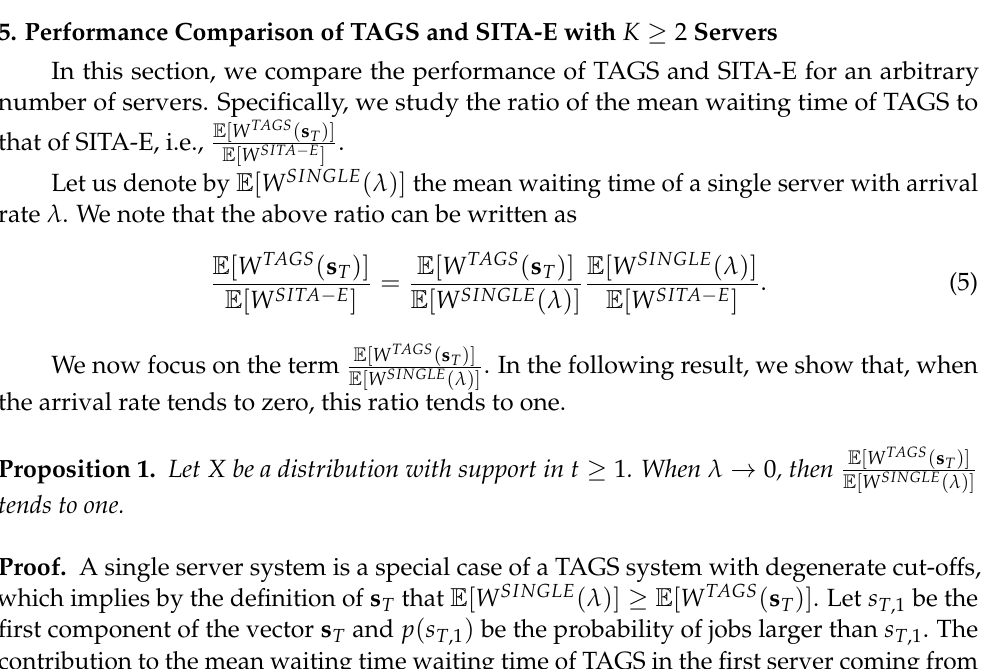
Figure 3. The ratio E [ W TAGS ( s T )] / E [ W SITA ( s T )] as a function of r for different values of α . y-axis without units (it is the ratio of two values with the same unit) and for the x-axis the units are